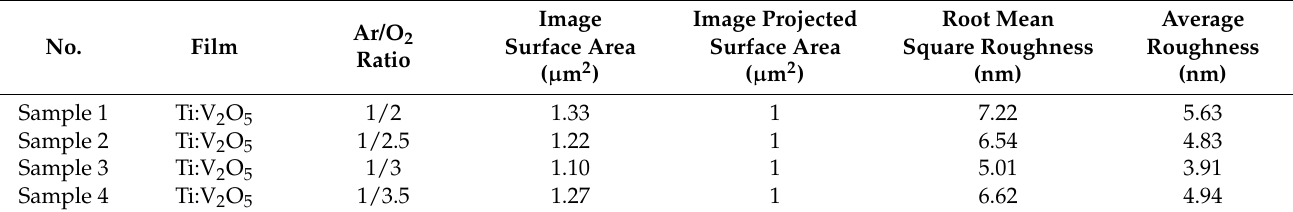
Table 3. Topographical parameters of Ti:V 2 O 5 counter electrode